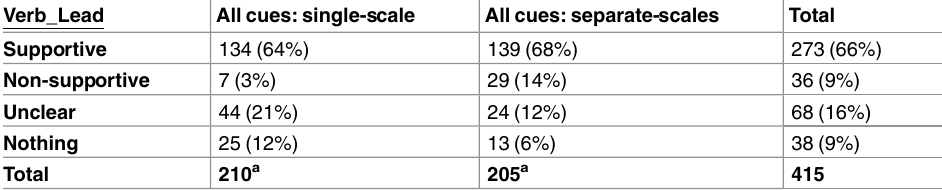
Nothing Total 210 a 415 a Each group evaluated 225 cues in total (9 per physician). Thirty-twocues were excluded (single-scale = 14; separate-scales = 18), as the physicians in question held no leading diagnosis at the time that these cues were evaluated (diagnostic likelihood = 0). Threecues were not verbally evaluated due to technical problems (single-scale = 1; separate-scales =